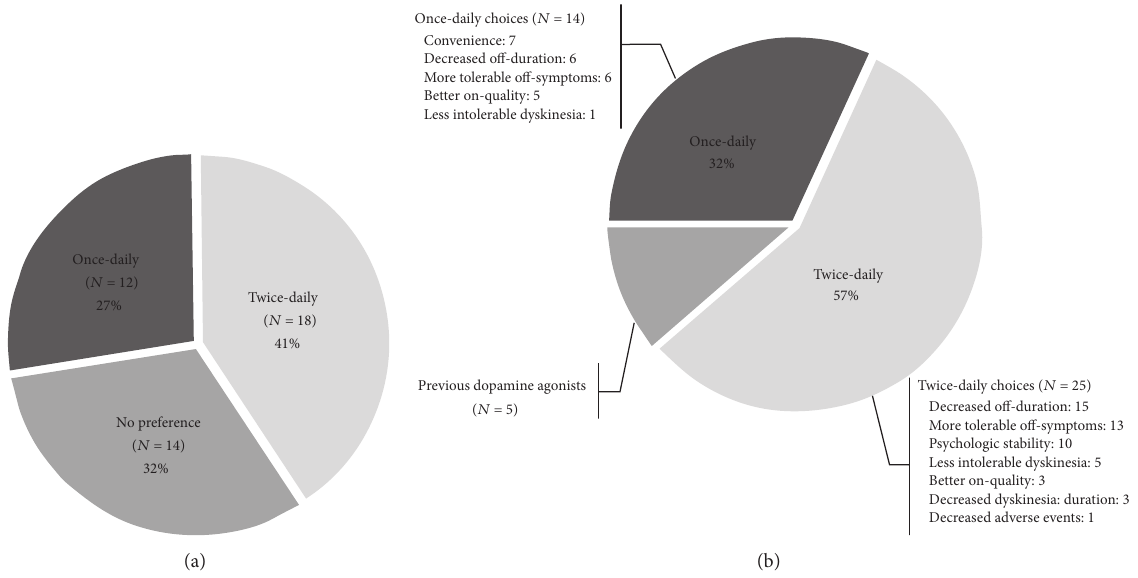
Figure 3: Patient’s preferences and choices in the end of the trial. (a) Preferences: in response to the final preference questionnaire, 27% ( n = 12) of the patients preferred the once-daily regimen, 41% ( n = 18) preferred the twice-daily regimen, and 32% ( n = 14) did not have a preference. (b) Patient’s choices in the end of the trial and reasons. In response to the final choices questionnaire, 32% ( n = 14) of the patients wanted to take the once-daily regimen, 57% ( n = 25) chose the twice-daily regimen, and 11% ( n = 5) wanted to revert to previous dopamine